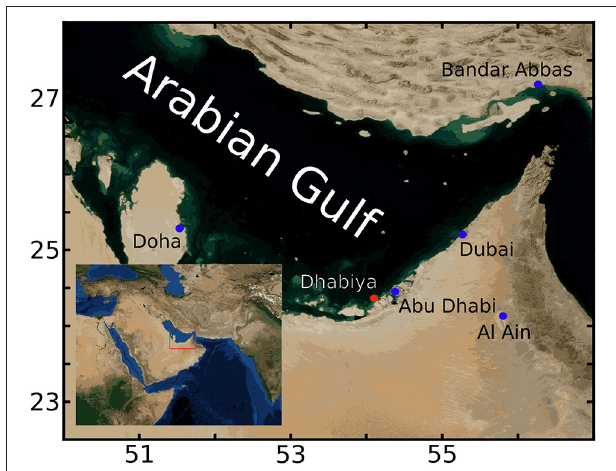
FIGURE 1 | Region of study within the Gulf. Red dot indicates the location of Dhabiya reef, with nearby Gulf cities designated by blue dots. Inset shows study region (red rectangle) located within greater southwest Eurasia. This figure is generated using Blue Marble: Next Generation data provided by Reto Stöckli, NASA Earth